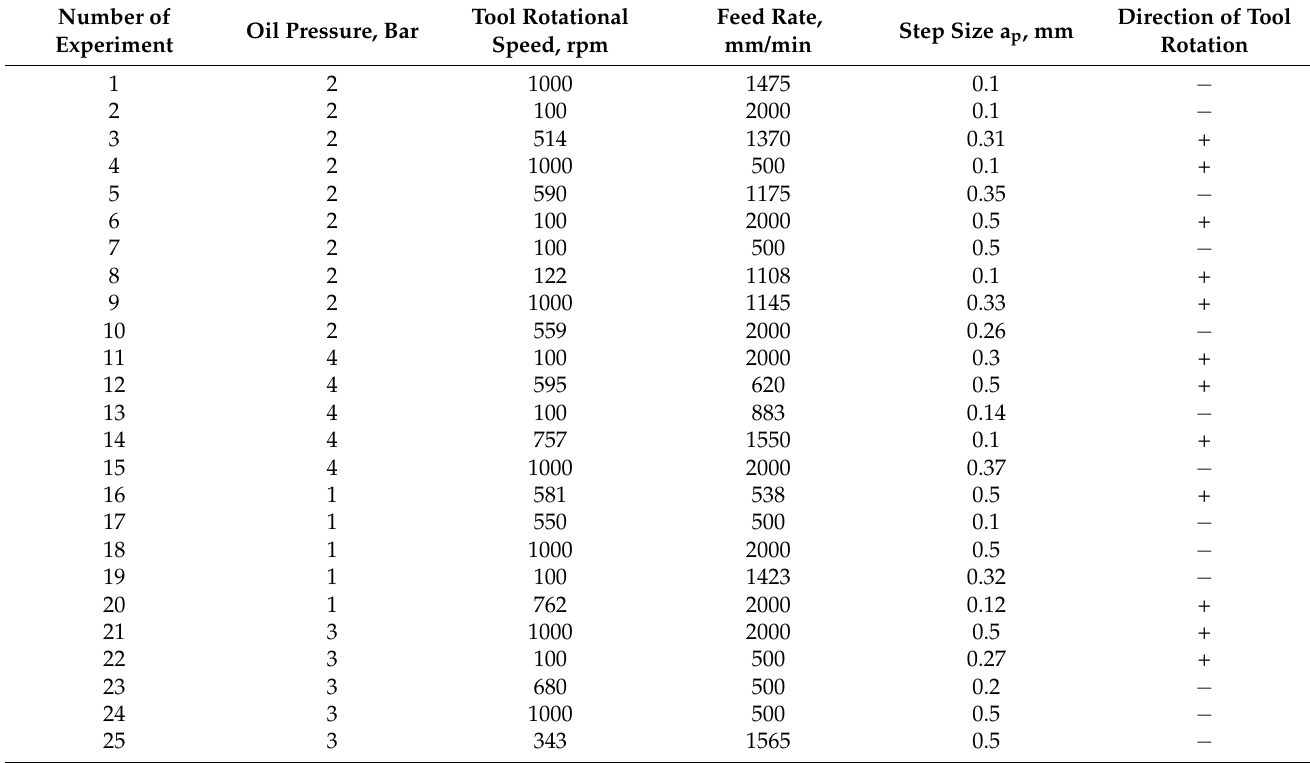
Table 3. Plan of experiments for split-plot I-optimal design (“+”—clockwise direction, “ − ”— counterclockwise direction of tool